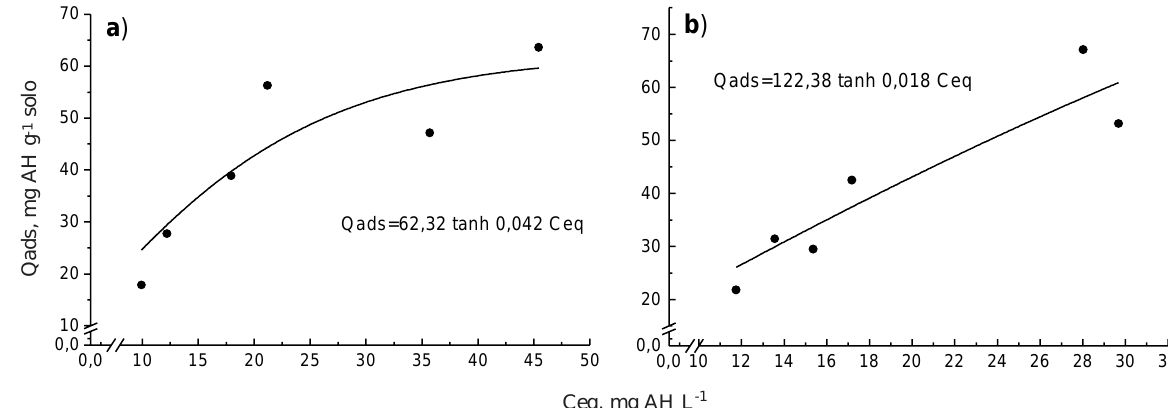
Figura 2. Isotermas de adsorção de ácidos húmicos extraídos de a) solo e de b) carvão em Latossolo Roxo tratado com oxalato de amônio. Ceq = concentração de AH em equilíbrio e Qads = AH adsorvido. Os coeficientes de determinação das equações são apresentados no quadro 3.